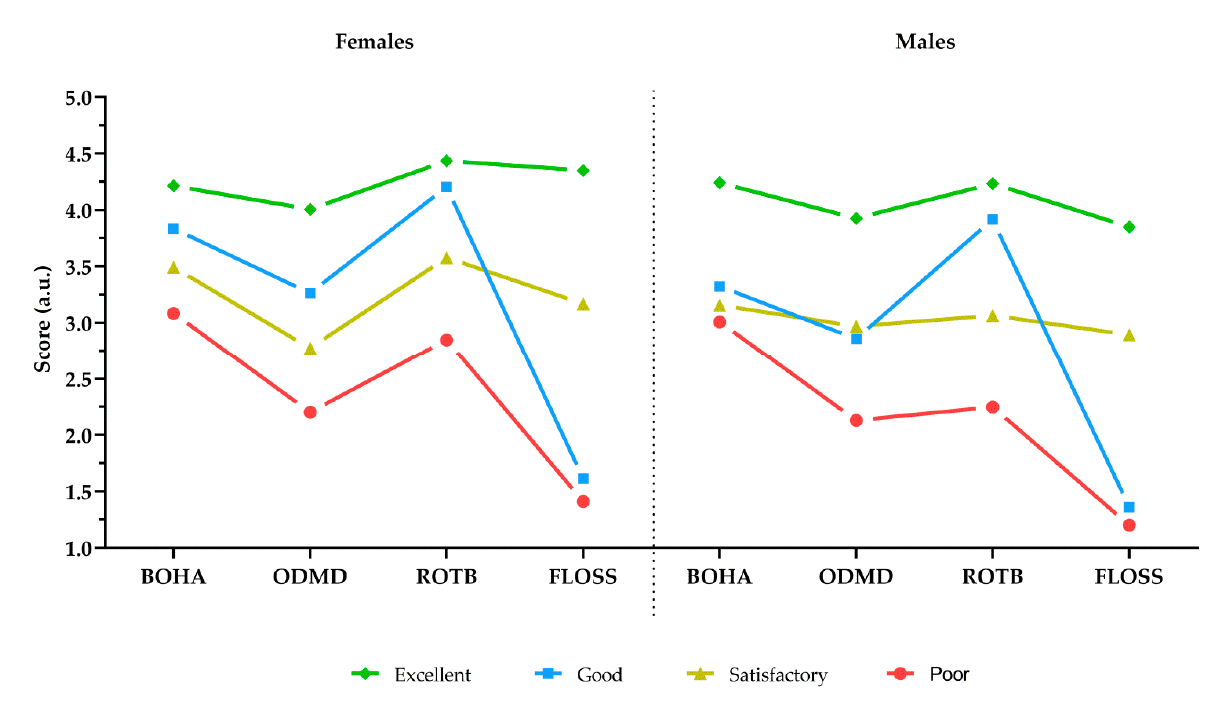
Figure 1. Female and male OH types. Descriptive statistics of self-reported oral status measures are shown in Table 6 in three separate sections. Table 6. Descriptive statistics of self-reported oral status measures.